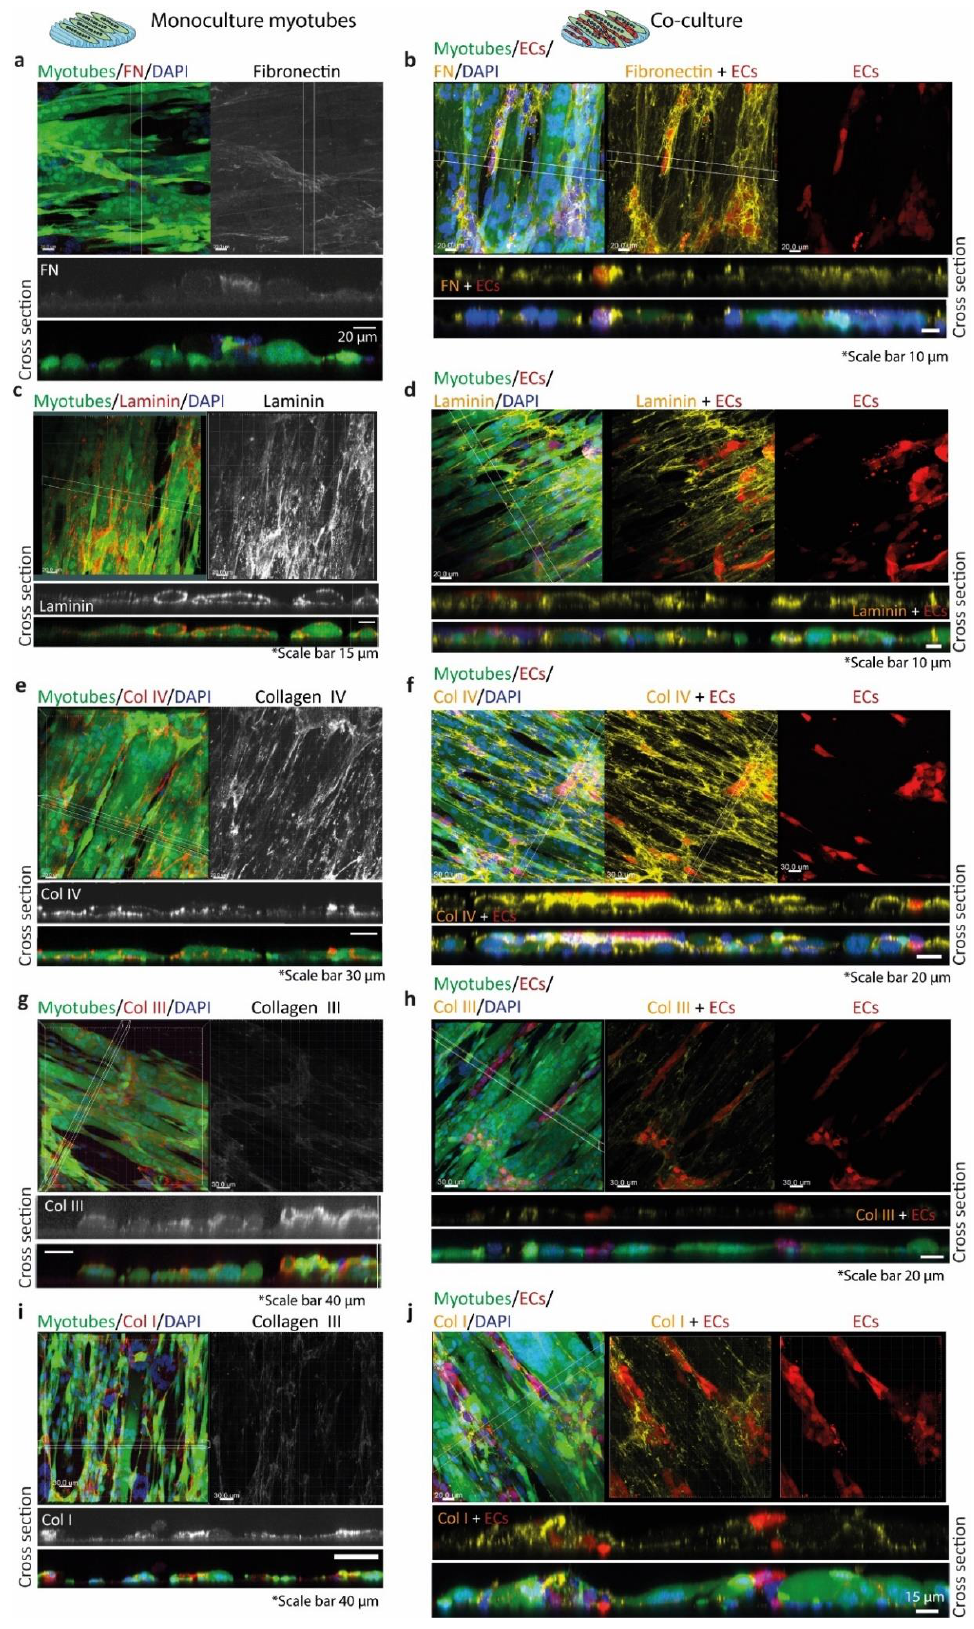
Figure 7. Extracellular matrix protein deposition by myotubes (left column) and co-cultured ECs and myotubes (right